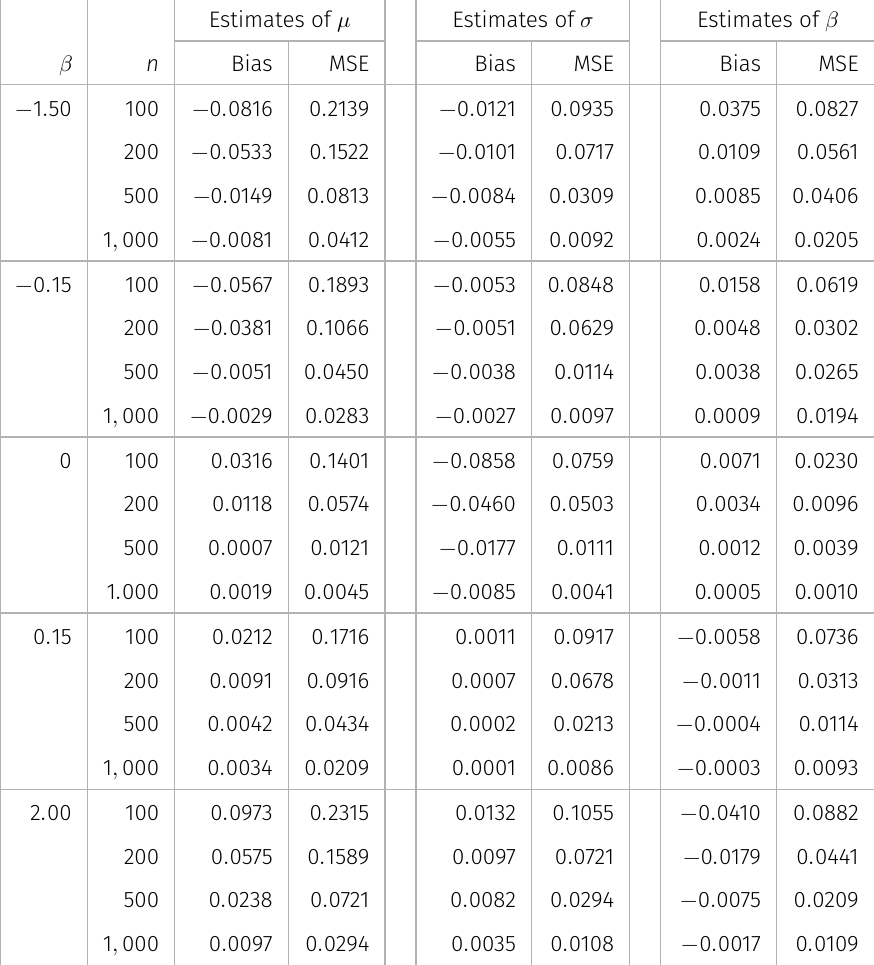
Table I. Bias and MSE of the MLE of unknonw parameter for the BSL distribution. Estimates of 𝜇 Estimates of 𝜎 Estimates of